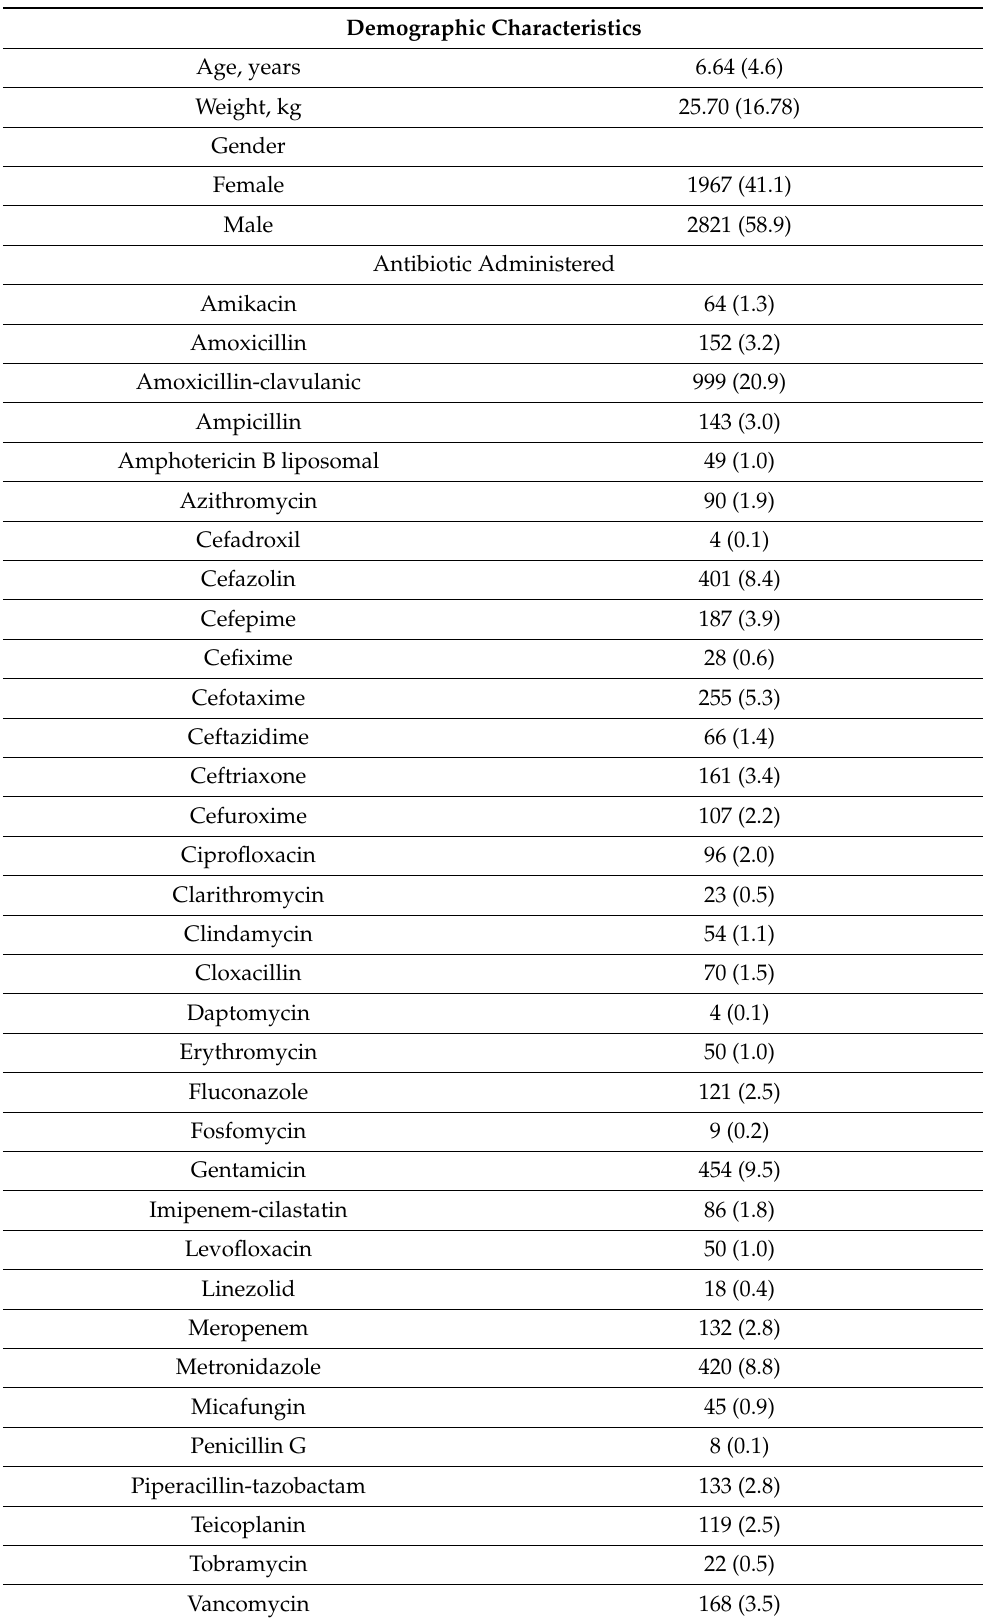
Table 2. Demographic characteristics of the pediatric patients and the treatments